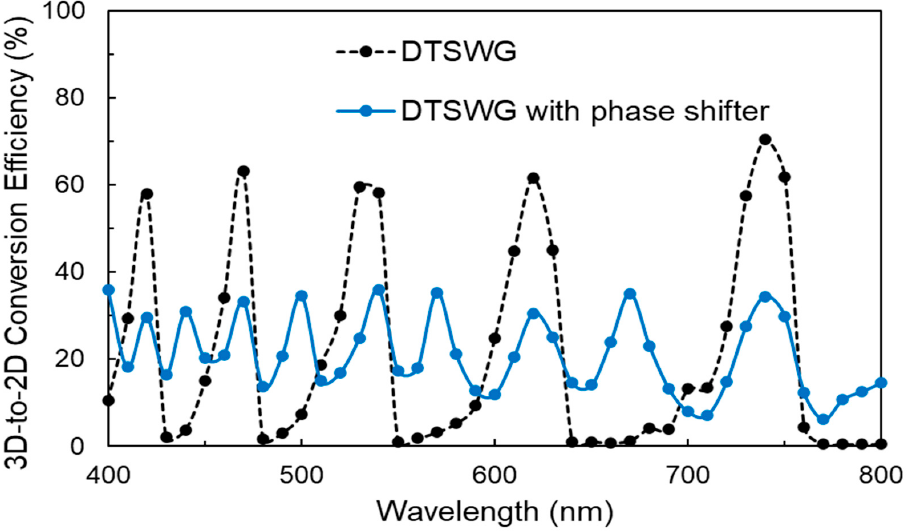
Figure 7. Wavelength dependence of the efficiency of DTSWG and DTSWG with phase shifter.